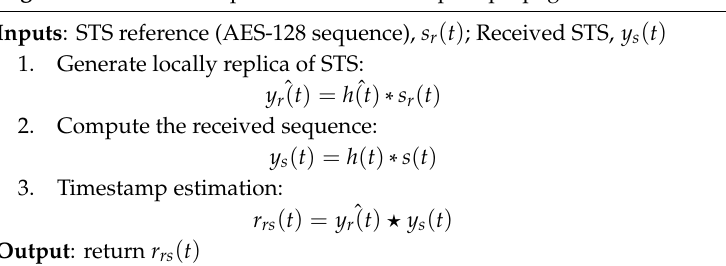
Algorithm 1 : Timestamp estimation in multipath